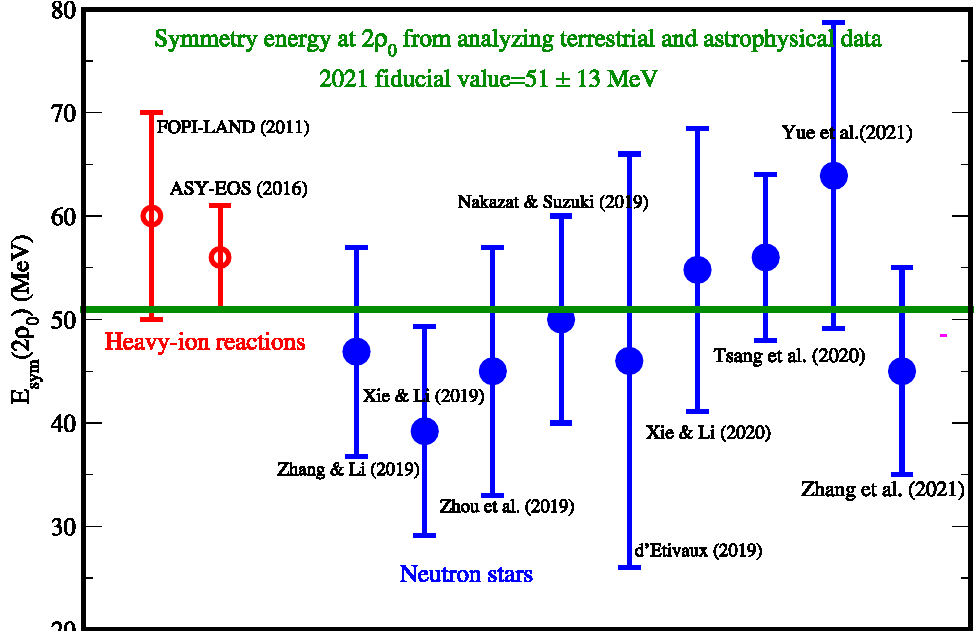
Figure 3. Nuclear symmetry E sym ( 2 ρ 0 ) at twice the saturation density of nuclear matter extracted from earlier heavy-ion reaction experiments in terrestrial nuclear laboratories (red) and 9 recent analyses of neutron star observables (see the text for the detailed list). The green line serving as the latest fiducial value of E sym ( 2 ρ 0 ) is the global average of all points